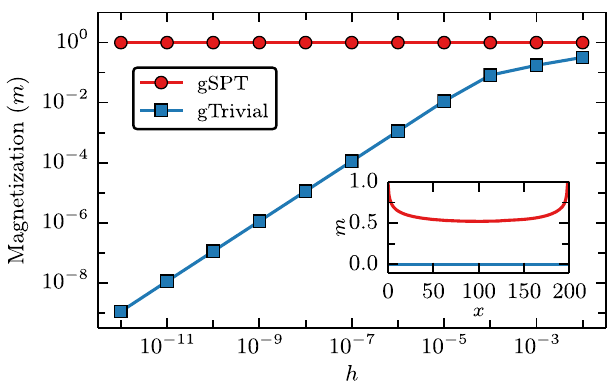
FIG. 3. Edge magnetization of the critical σ spins for typical gSPTand gTrivial ground states as a function of a small magnetic field. The ground states were computed on L ¼ 200 σ spins (and 200 τ spins) using DMRG, including small but arbitrary symmetry-preserving boundary perturbations. Inset: Spatial mag- netization profiles for a field h ¼ 10 − 10